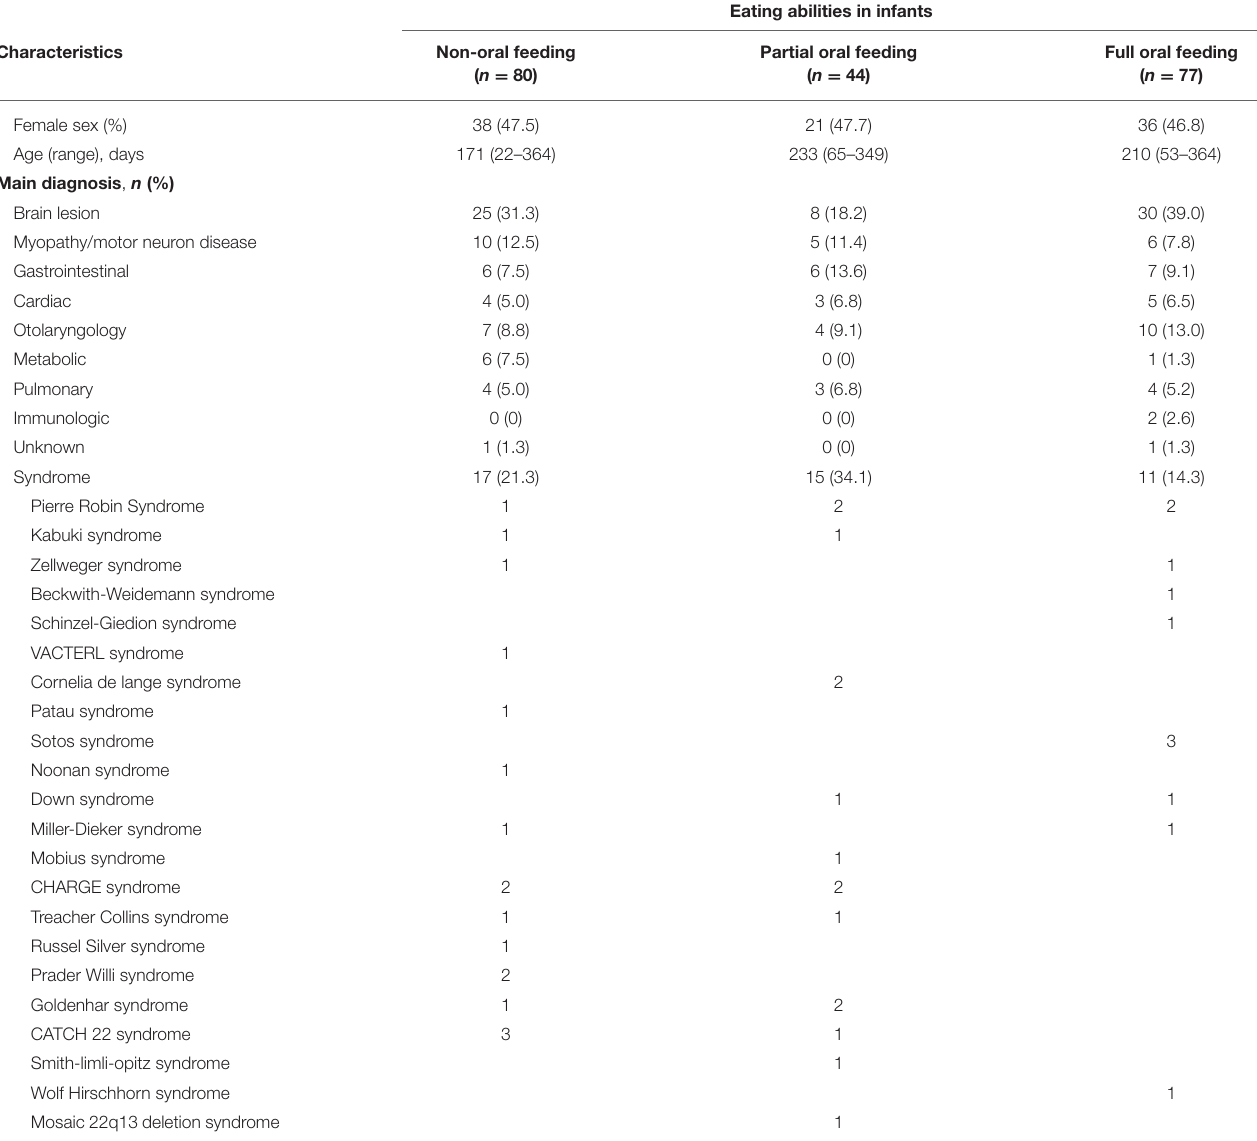
TABLE 4 | Characteristics of subjects at the time of the videofluoroscopic swallowing study. Characteristics Non-oral feeding